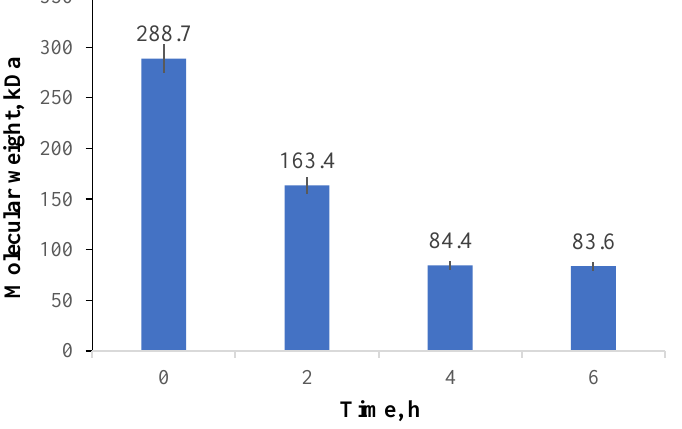
Figure 5. Variation of the average CMC molecular weight with the oxidation process duration determined by the viscosimetric method.